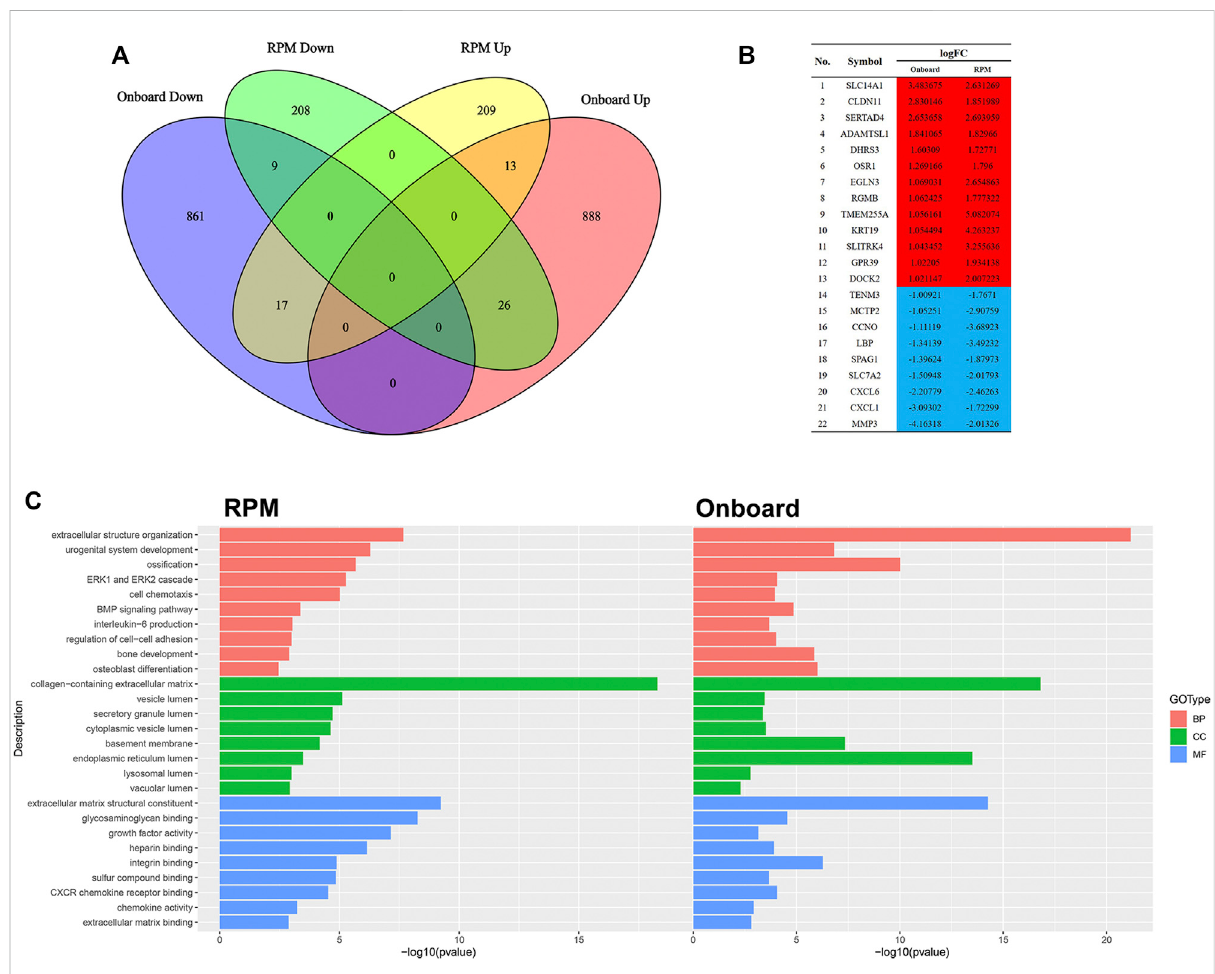
FIGURE 4 Comparison between Onboard and RPM (A) Venn diagrams of microgravity-sensitive genes in osteogenic medium from the Onboard (GSE100930) and RPM (GSE114117) datasets (B) Overlapping microgravity-sensitive genes in osteogenic medium from the Onboard and RPM databases. Red indicates upregulated genes, and blue indicates downregulated genes (C) Overlapping GO analysis results from the Onboard and RPM